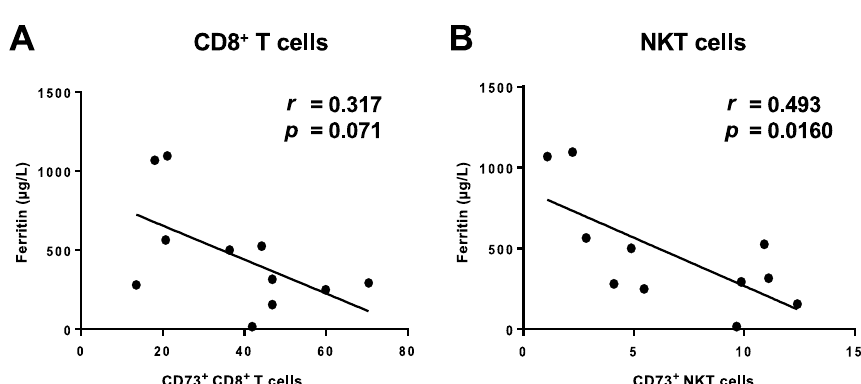
Figure 4. Correlation of CD73 with clinically-manifested inflammation. PBMCs from COVID-19 patients were analyzed ex vivo. Loss of CD73 expression on CD8 + T ( A ) and NKT cells ( B ) correlated with the serum ferritin level.